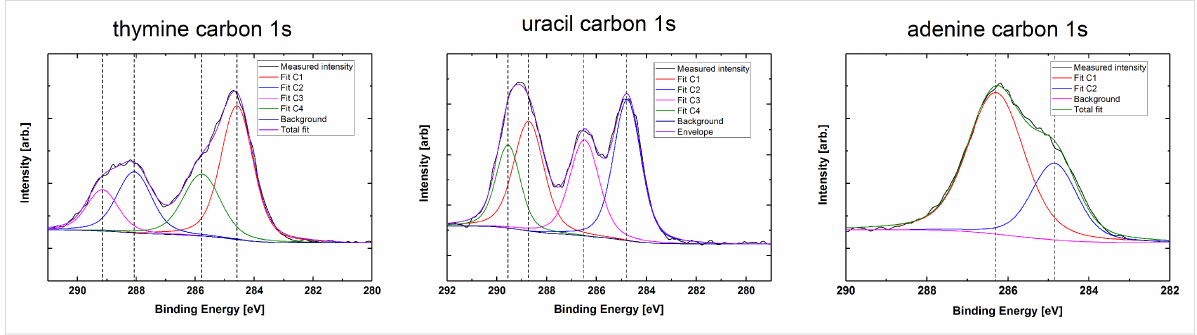
Figure 11: Carbon 1s for films based on adenine, thymine and uracil.